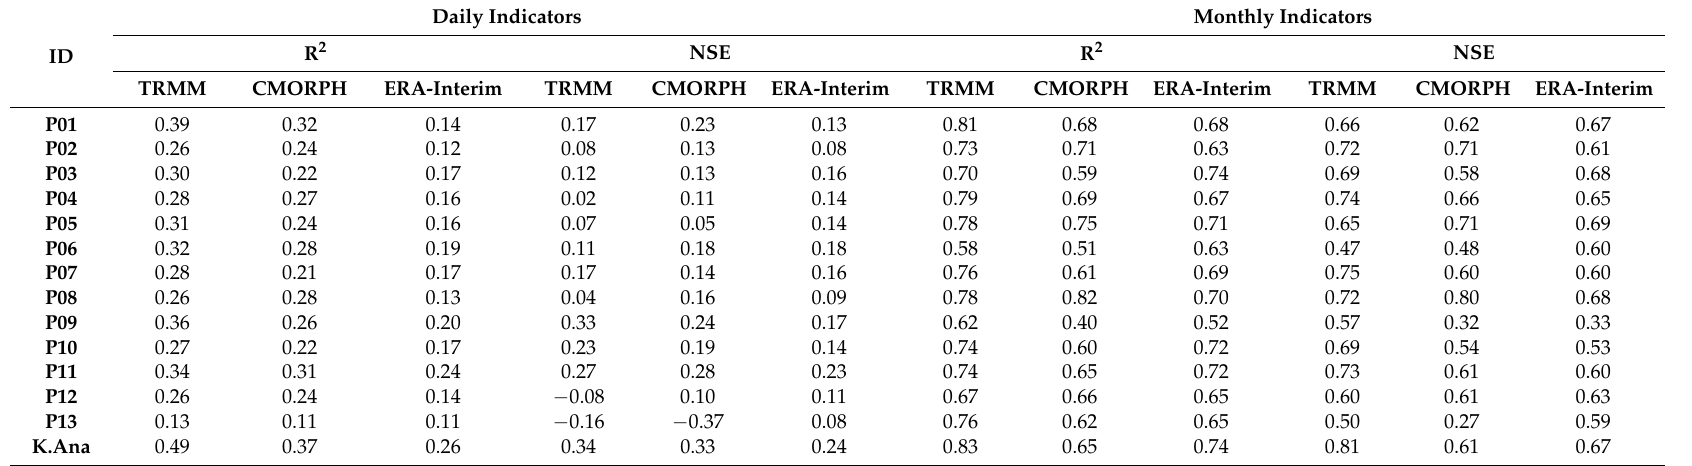
Table 4. Statistical indicators for the comparison between SBRP and GMP data